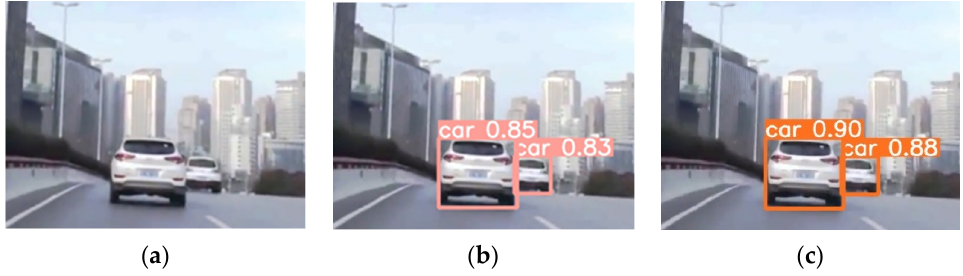
Figure 13. Visual comparison of loss function before and after improvement.